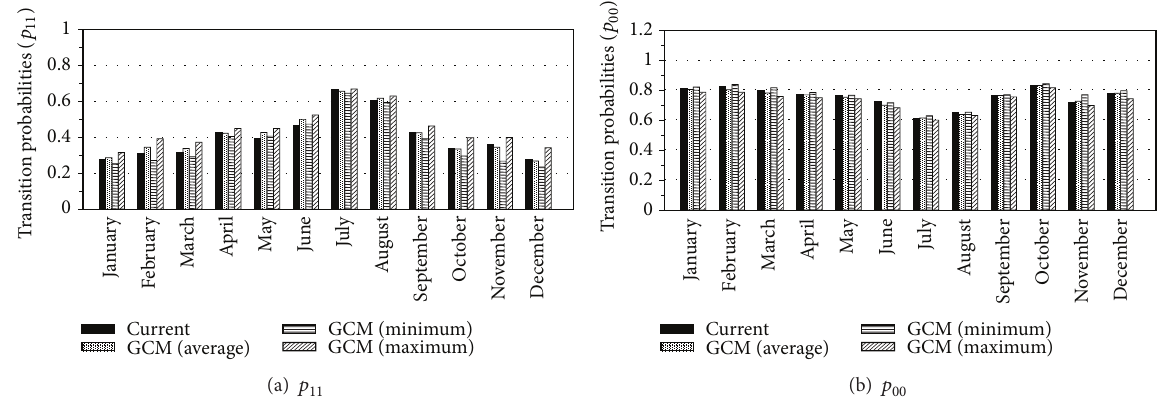
Figure 5: Transition probabilities 𝑝 11 and 𝑝 00 of current (1x CO 2 ) and 2x CO 2 (GCM average, minimum, and maximum) conditions.